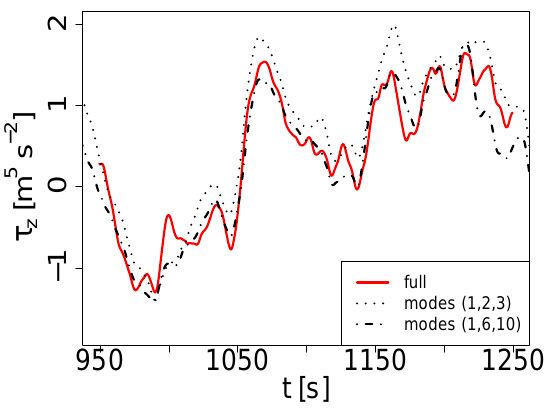
Figure 11. Torque-related measure τ a different set of three